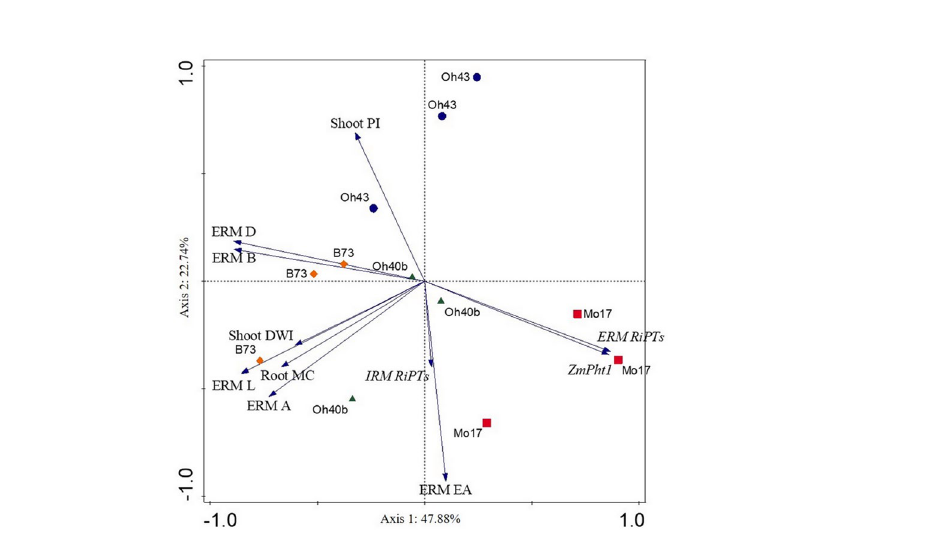
Figure 6. Principal Component Analysis (PCA) biplot showing the relations between physiological and molecular data collected from four Zea mays inbred lines grown under low phosphorus availability (0.47 mg kg −1 ) in symbiosis with Rhizoglomus irregulare . Standardized data of R. irregulare extraradical